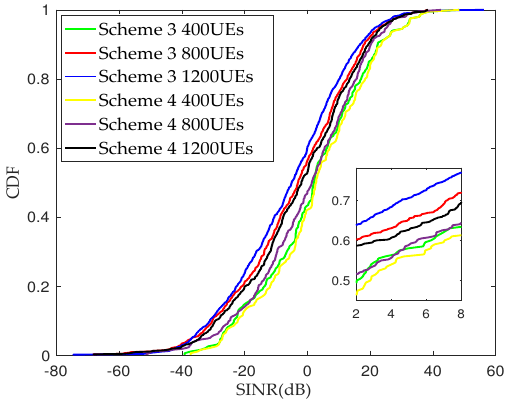
Figure 8. Signal-to-interference-plus-noise ratio (SINR) cumulative distribution functions (CDFs) with various numbers of UEs.